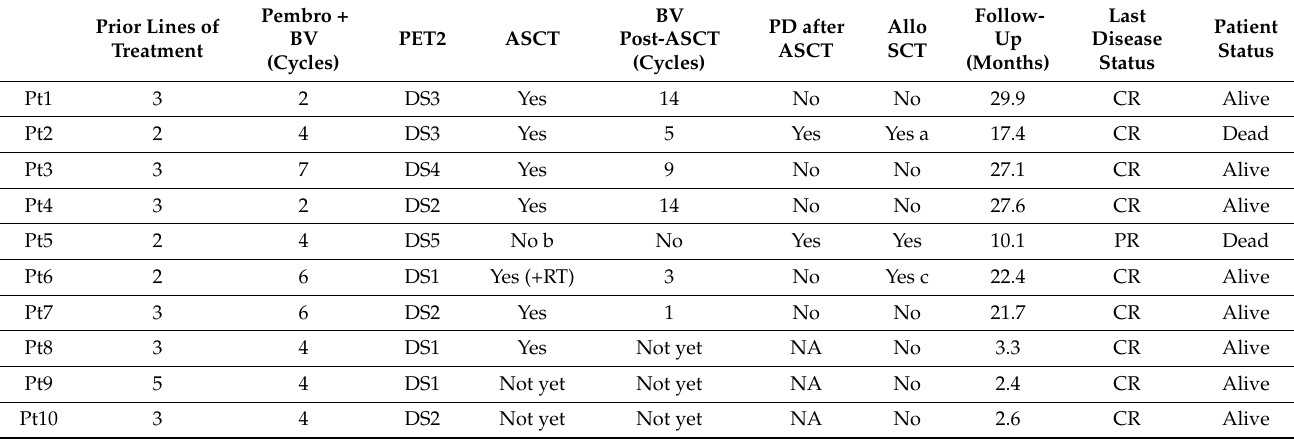
Table 2. Treatment details for each patient in study.